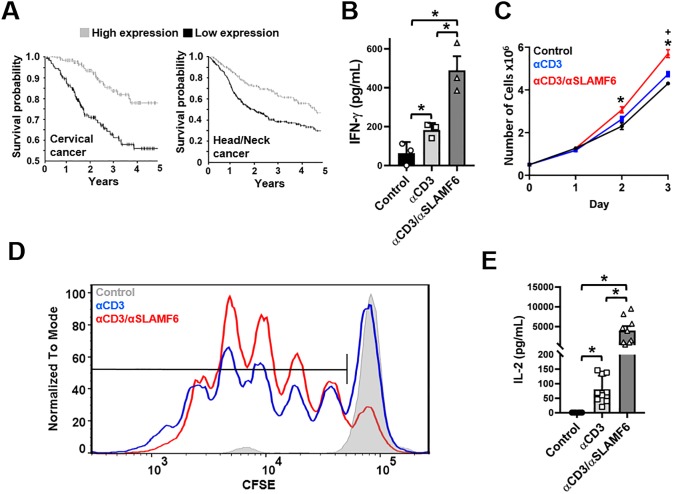
SLAMF6 antibody engagement leads to T cell activation.(A) Survival curves demonstrating that high expression of SLAMF6 in tumors is positively correlated with cancer survival. (B) Freshly isolated primary CD3+ T cells were cultured in the presence of αCD3 or αCD3 + αSLAMF6. After 48 hrs. the supernatant was harvested and IFN-γ levels were analyzed by ELSIA for two independent experiments (n = 2) with 3 technical replicates of one experiment shown. *p<0.05 for an unpaired student t-test (C) Jurkat T cells were cultured in the presence of αCD3 or αCD3 + αSLAMF6 for 72 hrs. Cell number was assessed by automated cell counting every 24 hrs. The experiment was done in triplicate (n = 3). *p<0.05 for αCD3 + αSLAMF6 compared to control and + p<0.05 for αCD3 compared to control for an unpaired student t-test. (D) Freshly isolated primary CD3+ T cells were stained with CFSE then cultured in the presence of immobilized αCD3 or αCD3 + αSLAMF6. After 120 hrs. the cells were assayed for FITC fluorescence for three independent experiments (n = 3). The data was analyzed for percent (%) of proliferating cells as depicted; αCD3 + αSLAMF6 had a 15–25% greater proliferation advantage over αCD3 alone conditions. (E) Also, the supernatant was harvested, and IL-2 levels were analyzed by ELSIA for three independent experiments (n = 3) with 3 technical replicates for each experiment shown together. *p<0.05 for an unpaired student t-test.